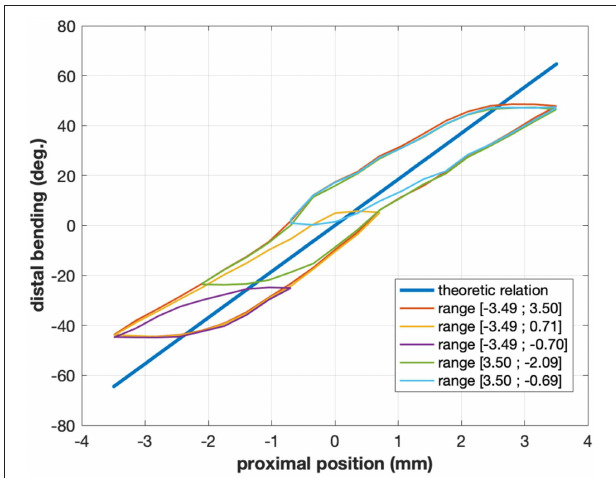
FIGURE 2 | Typical relations between proximal motor position and distal angle for the cable-actuated bending DOF of the STRAS robot ( Zorn et al., 2018). The straight line shows the theoretic model relation, while the hysteretical curves show the actual relation for a given configuration of the passive shaft of the robot. Different colors correspond to different ranges of motor motions and highlight the complex behavior of this joint. The actual relation also changes when the shape of the shaft is